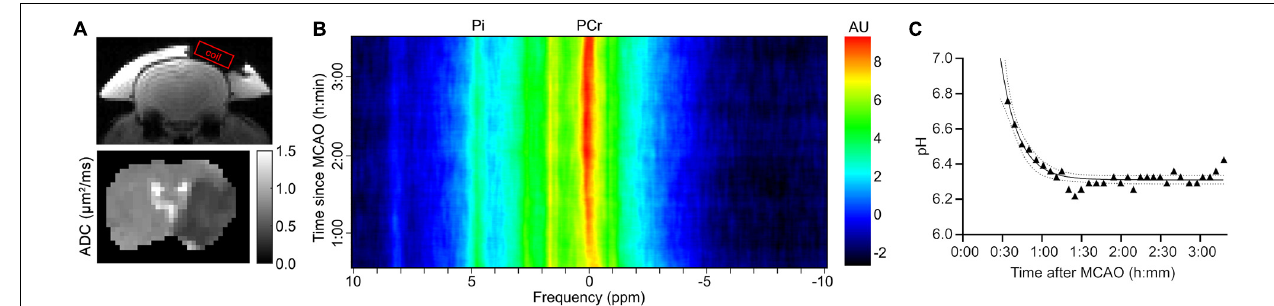
FIGURE 1 | Example of an estimation of pH over time using a rolling average acquisition in an experiment in a male SD rat that underwent 31 P spectroscopy after a MCAO. (A) The position of spectroscopy coil and apparent diffusion coefficient (ADC) map ( µ m 2 /ms) of the rat brain, showing the extent of the infarct. (B) Image map showing rolling average spectral data against time after MCAO, with the positions of the PCr and Pi peaks indicated. Note the decreasing separation of the two peaks as the time increases. Each rolling average period is 300 FIDs, or 15 min. (C) Scatter plot of pH calculated according to Eq. (1) against time after MCAO. Solid line is a fitted one-phase exponential decay with 99% confidence intervals indicated by the dashed lines.